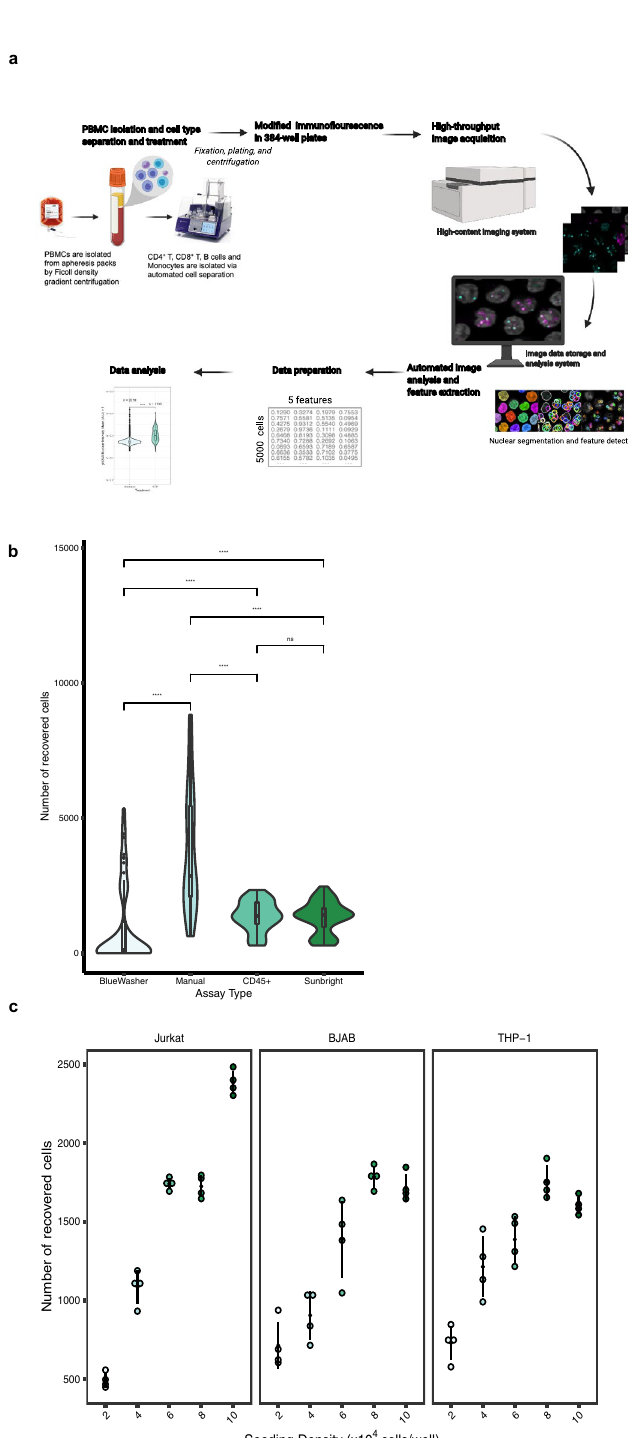
Figure 1. HiIDDD: High-throughput imaging of DNA damage in human immune cells. ( a ) Schematic representation of the high-throughput imaging methodology to detect DNA damage in CD4 + T, CD8 + T, B cells and monocytes. The pipeline involves a modified immunofluorescence assay, imaging using an automated high- content screening system, image analysis for segmentation and fluorescence intensity cellular features extraction, and statistical analysis. Created with BioRender.com. ( b ) Determination of seeding efficiency using DAPI staining ~ 15 h after seeding. Additional substrates were added to poly-D-lysine plates; cells were seeded using a BlueWasher liquid handler unless indicated otherwise. Values represent at least 48 replicate wells per condition; box represents first and third quartiles. ( c ) Jurkat, BJAB, and THP-1 cells were seeded at densities ranging from 2–10 × 10 4 cells/well in a 384-well format. The total number of detected nuclei by DAPI is indicated. N = 4 wells per condition with at least 467 cells per